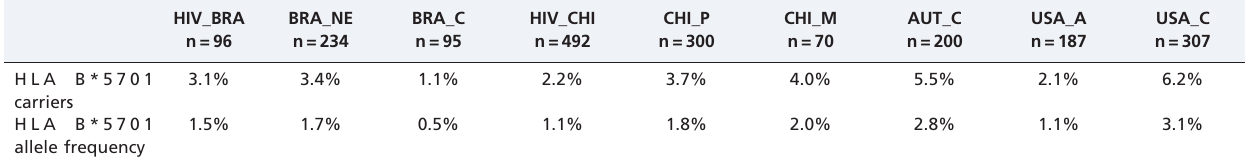
Table 1 - HLA B*5701 frequencies in HIV-infected patients (HIV_BRA) and the controls (BRA_NE) from Northeast Brazil in this study and in previously genotyped populations 9 (http://www.allelefrequencies.net).